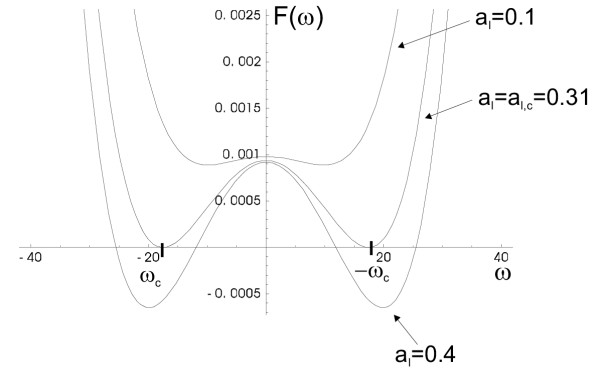
Emergence of Turing instability. As aI increases through its critical value, the function F(ω) (equation (17)) crosses zero. Negative regions of F(ω) correspond to unstable wave-numbers. The wave-number which becomes unstable first is denoted by ωc. The parameters are as follows: r = 1; δ = 0.1; aP = 5; bP = 0.1; bI = 0.01; DC = 0.00001; DI = 0.001.